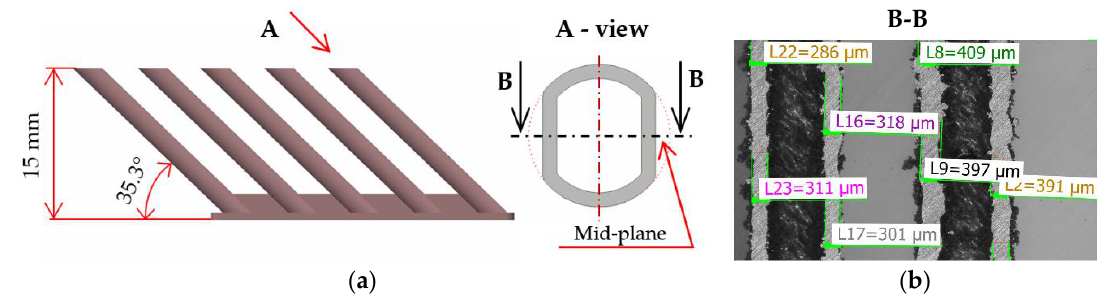
Figure 6. ( a ) A special shape of strut designed for evaluation of the width of hollow strut walls without distortion caused by inclined grinding plane; ( b ) wall width measurement using macro images captured by the light microscope.